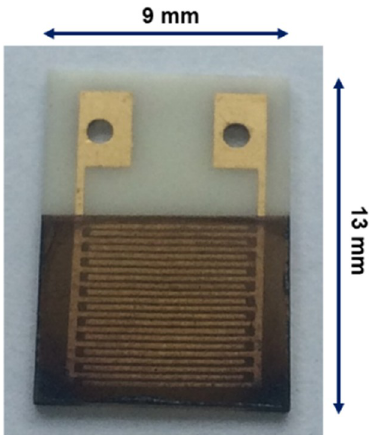
Figure 1. A photo of the sensor device using Cu 2 O NCs deposited on an alumina substrate with Au microelectrodes.